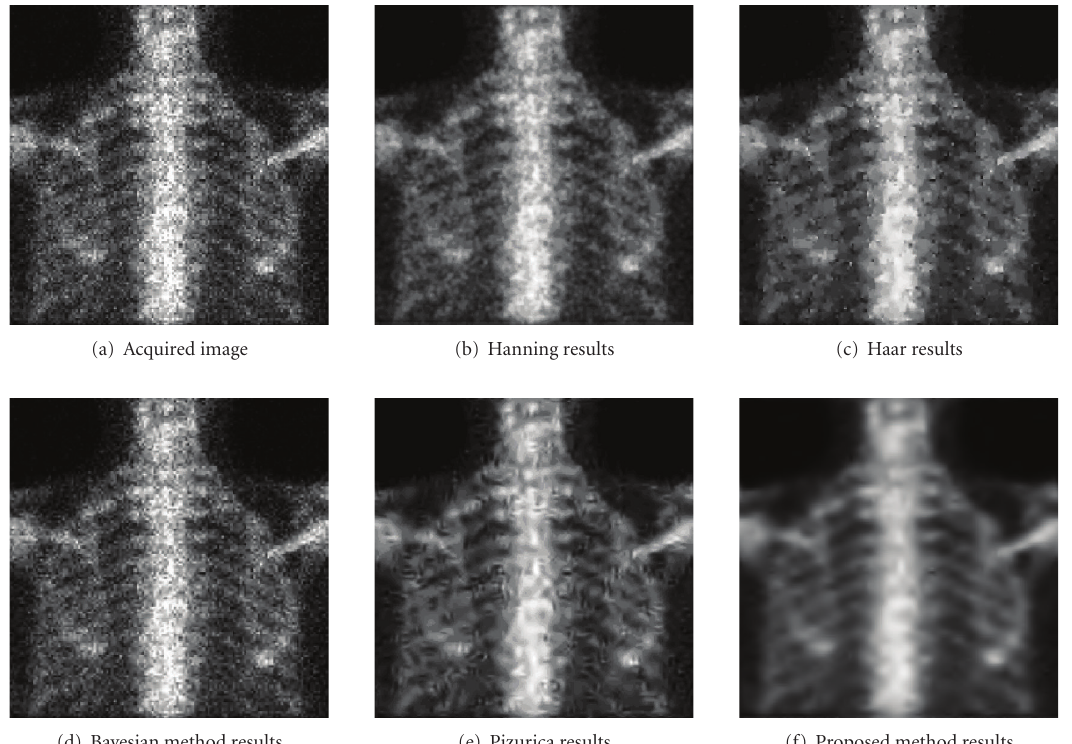
Figure 4: Comparison of the method with several other methods, on a bone scintigraphic image.